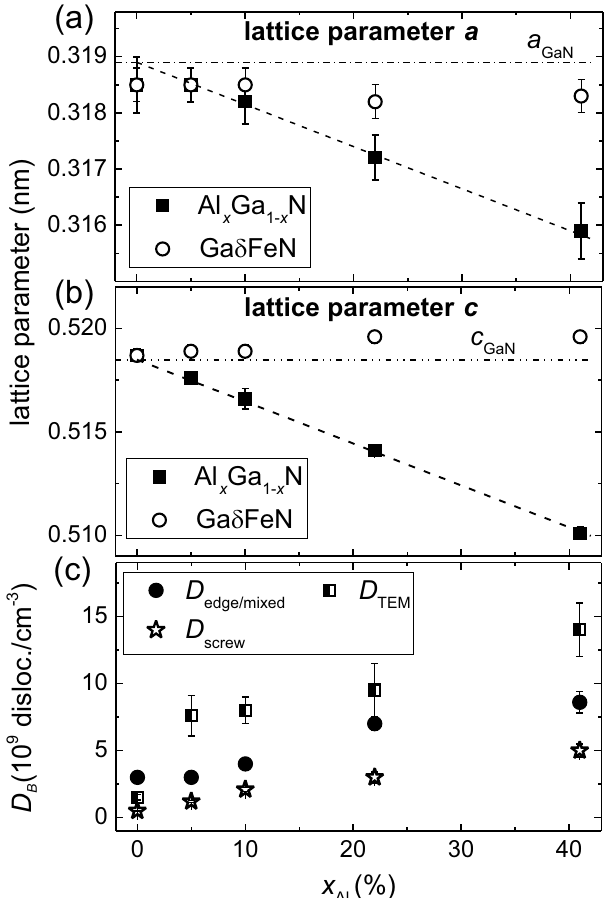
Figure 3. ( a , b ): Lattice parameters a and c of the Al x Ga 1 − x N buffer (full squares) and the Ga δ FeN layers (empty circles) vs. x Al . The dashed line corresponds to the Vegard’s law and the dashed-dotted line indicates the literature values of the lattice parameters a and c for GaN[31]. ( c ) Dislocation densities—edge-mixed (full circles) and screw (empty stars)—in the Al x Ga 1 − x N buffer layers estimated from XRD and TEM (half-filled squares) as a function of x Al